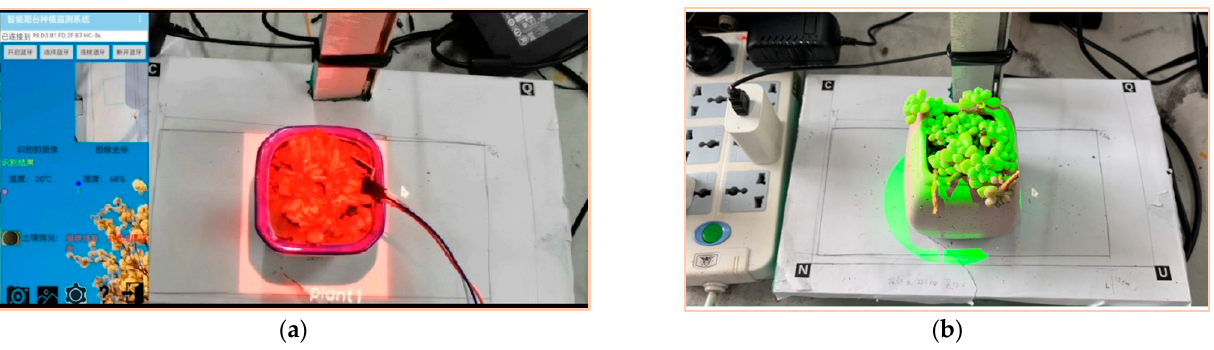
Figure 8. Demonstration of AR teaching resource created by students for plant lighting based on the proposed AR method, where the learning-based CCD detection and warp-based DLP mapping provides users interact with the plant and the light, such as adapting the location ( a ) and the shape ( b ) of light to the plant at a place dynamically.